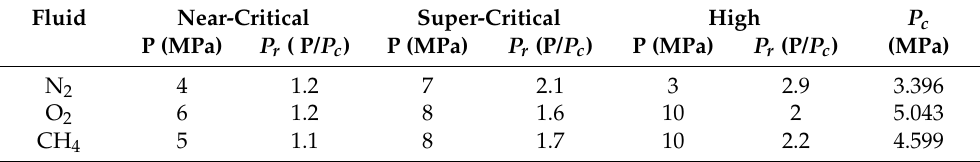
Table 2. Table of respective supercritical pressures of three cryogenic fluids (N 2 , O 2 and CH 4 ) for which the thermophysical properties were estimated using EoS and the EoS–Chung model, where P c is the critical pressure and P r is the reduced pressure of the respective